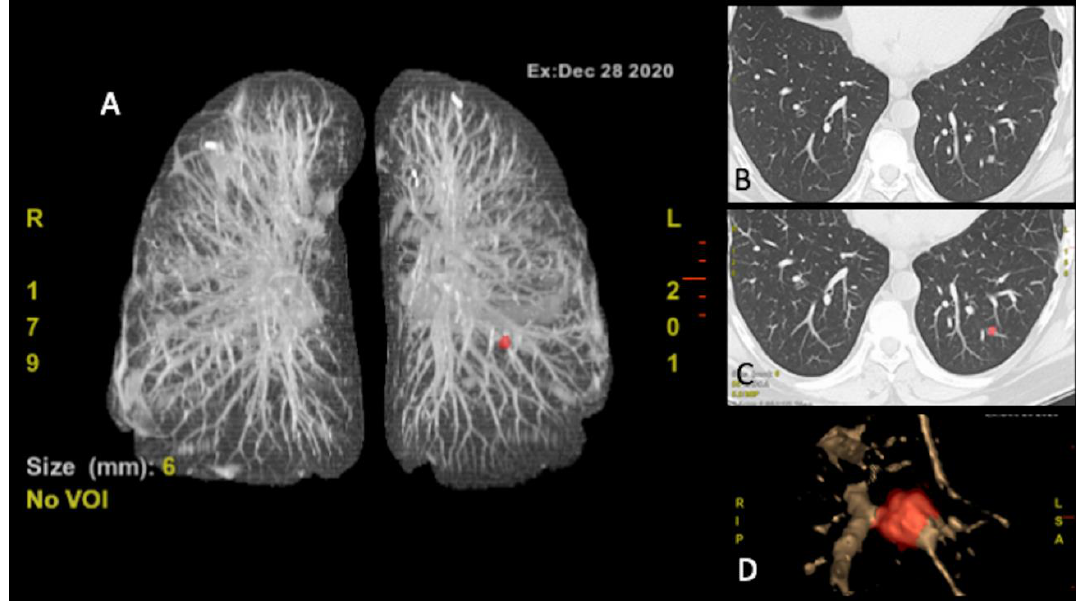
Figure 3. Computer-aided diagnosis (CAD) CT ( A ) figure nodule localizer (red), ( B ) CT scan, ( C ) CT scan nodule identification (red), ( D ) nodule volume rendering.